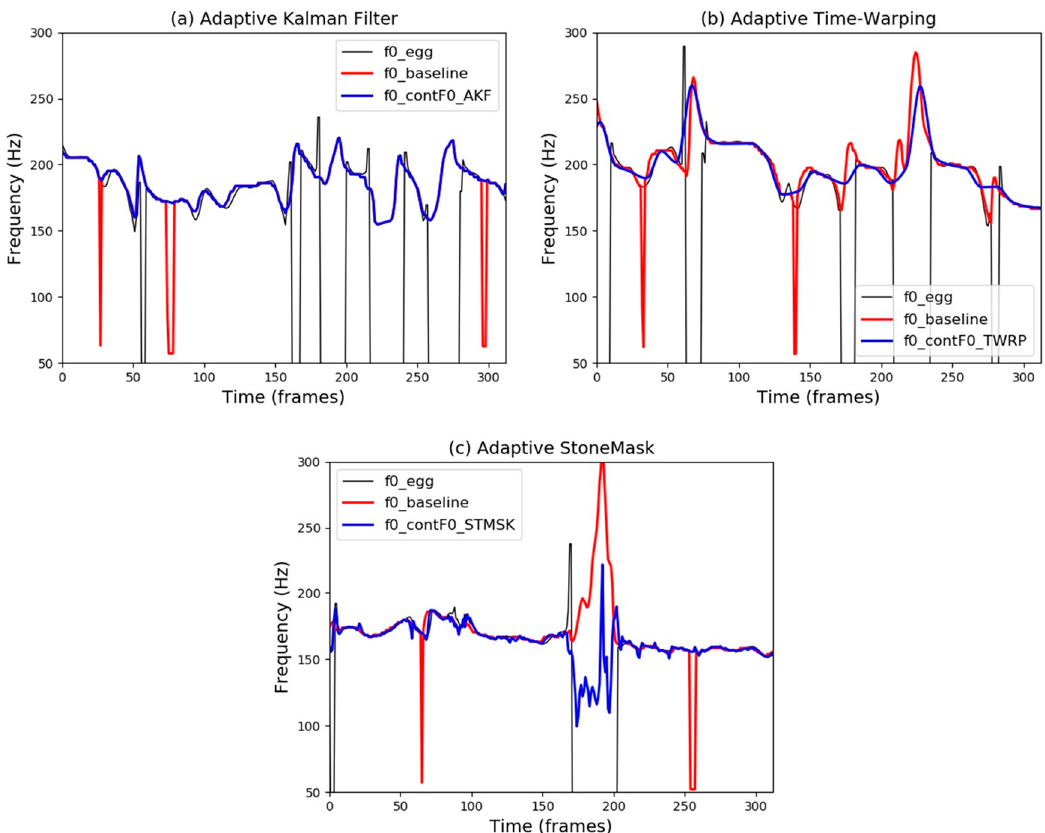
Figure 2. Examples from a female speaker of F0 trajectories estimated by the baseline (red) and ground truth (black) plotted along with proposed refined contF0 (adaptive Kalman filter (AKF), time-warping (TWRP), and StoneMask (STMSK)) methods.